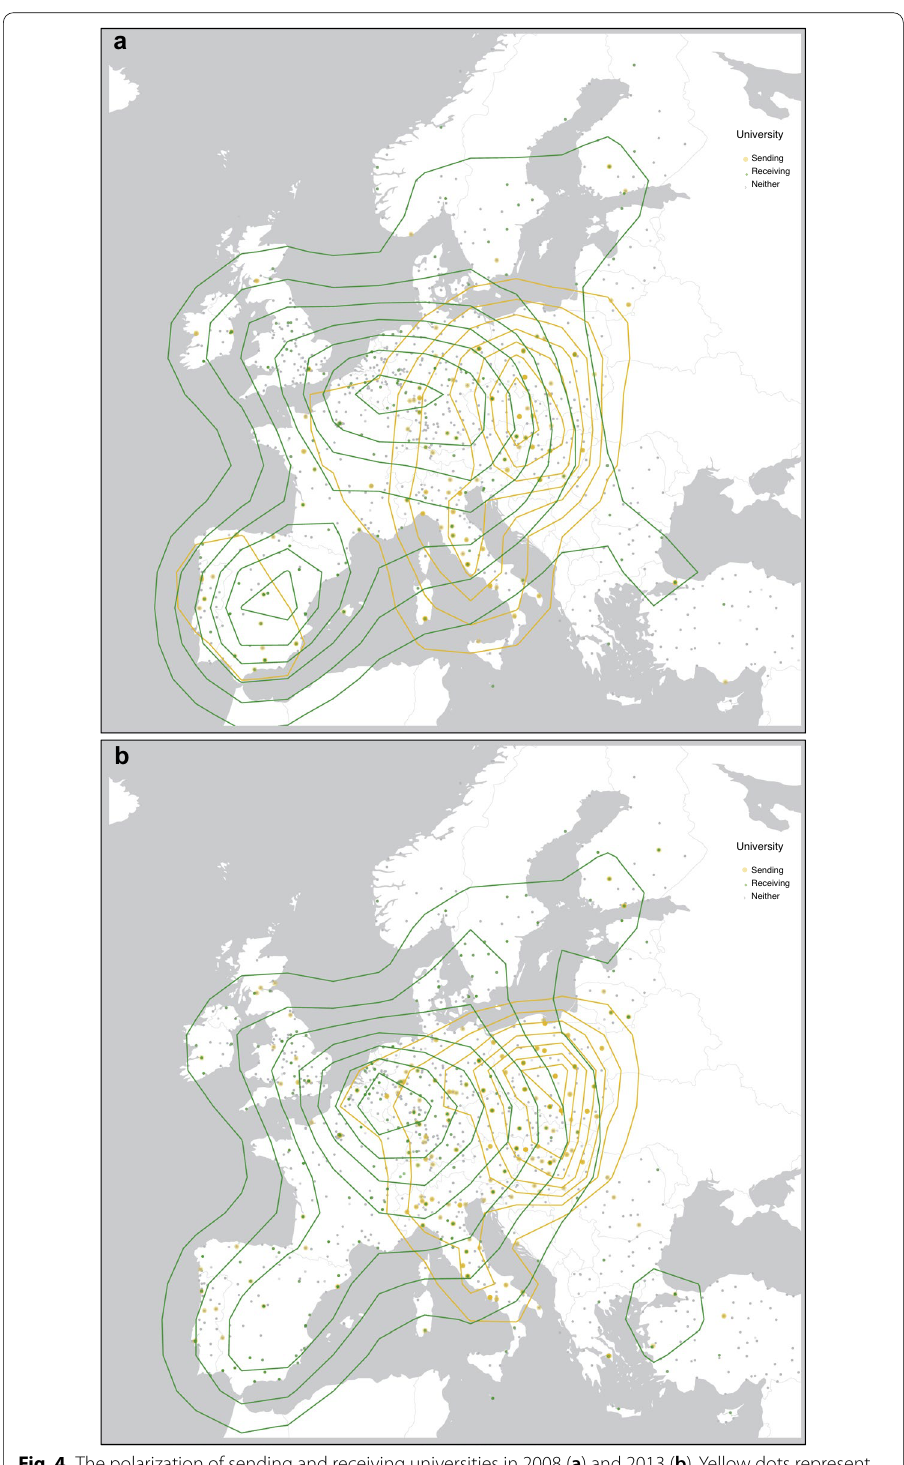
Fig. 4 The polarization of sending and receiving universities in 2008 ( a ) and 2013 ( b ). Yellow dots represent sending universities. Green dots represent receiving universities. Grey dots represent universities that neither send nor receive Erasmus students with special needs. The yellow contour visualizes the density of sending universities. The green contour visualizes the density of receiving